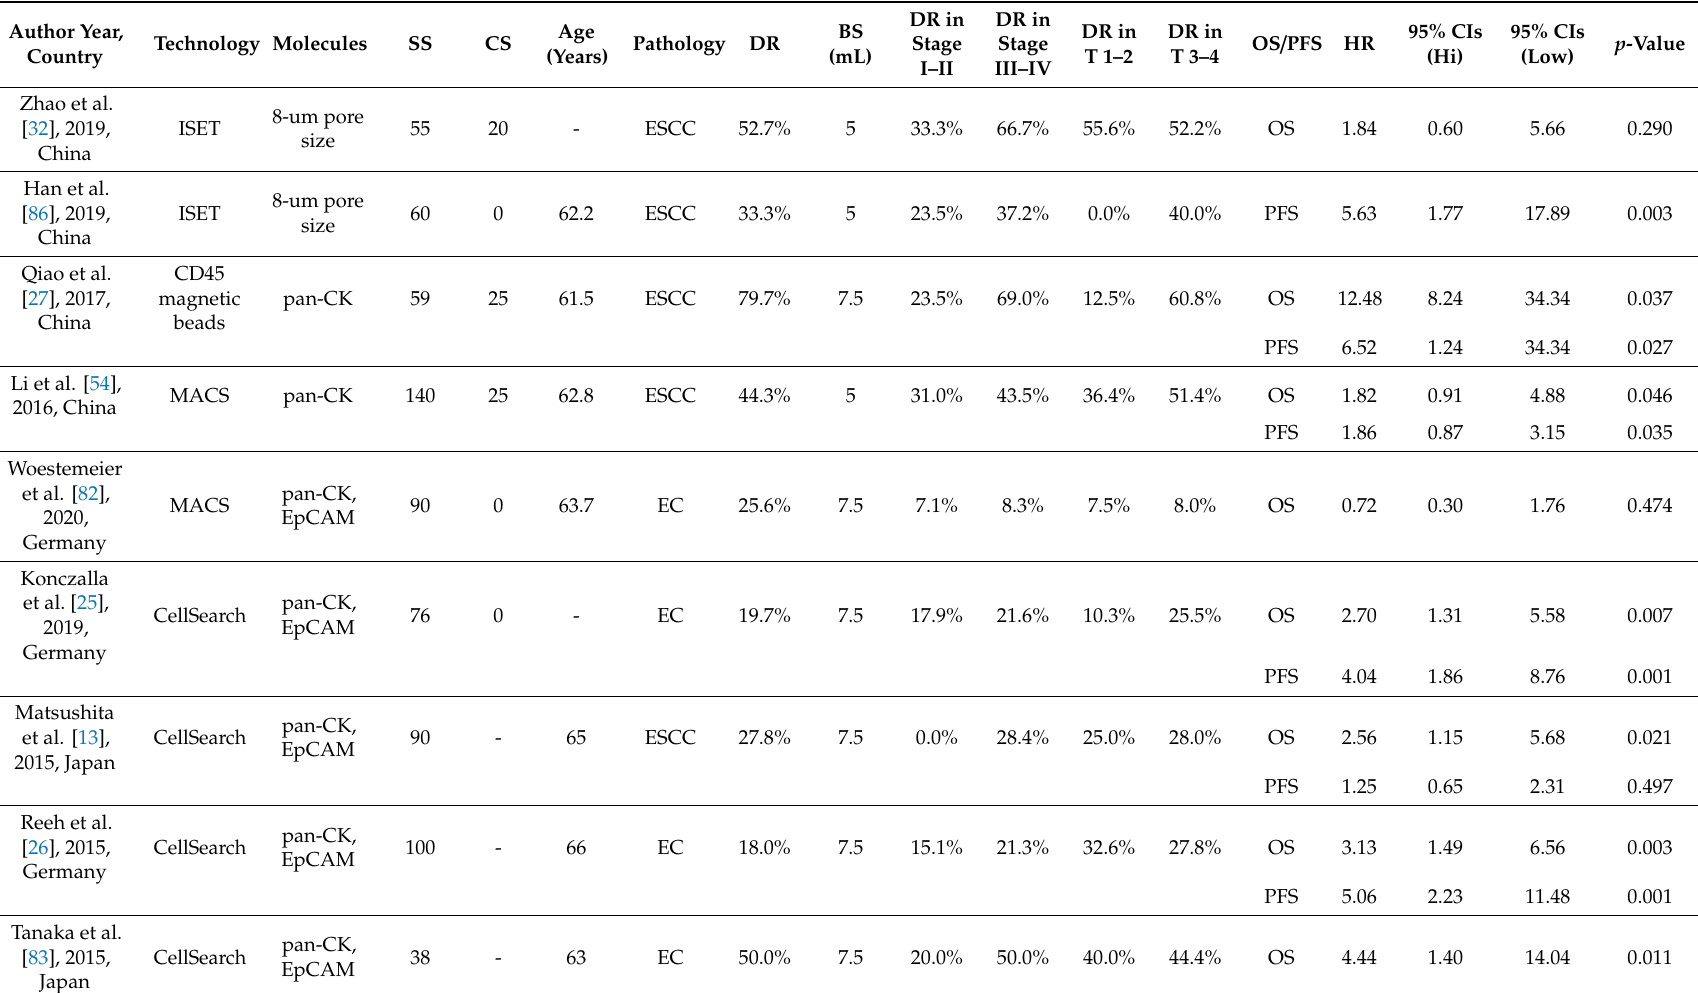
Table 1. The results of liquid biopsies for prognostic evaluation in the cytometric